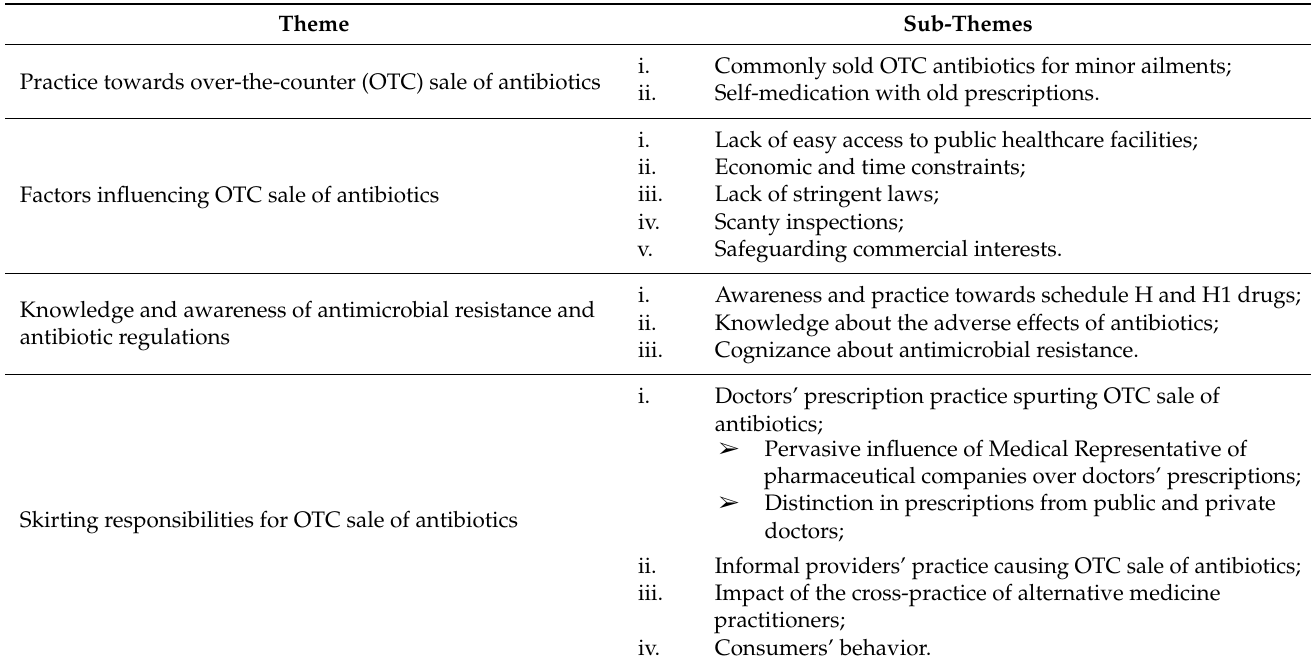
Table 2. Themes and sub-themes derived through systematic thematic analysis of